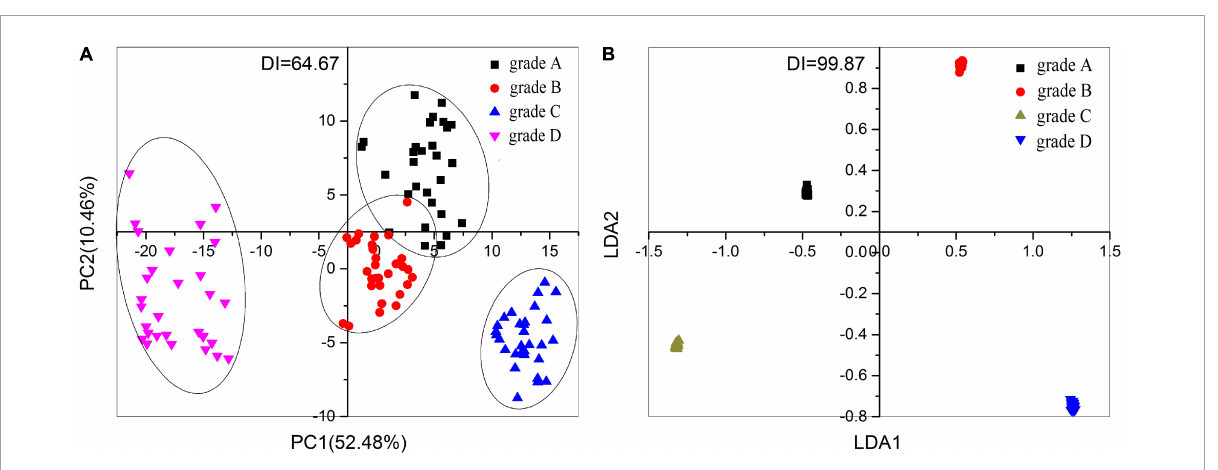
4-methylpentanoate, ethyl hexanoate, hexyl acetate,